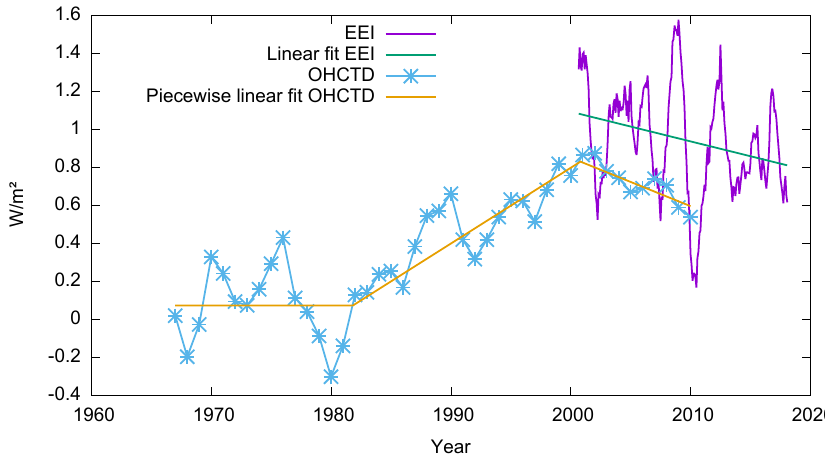
Figure 15. Purple curve: running yearly mean EEI. Green line: linear fit to running yearly mean EEI. Blue curve: 10 year running mean OHCTD. Orange curve: piecewise linear fit to